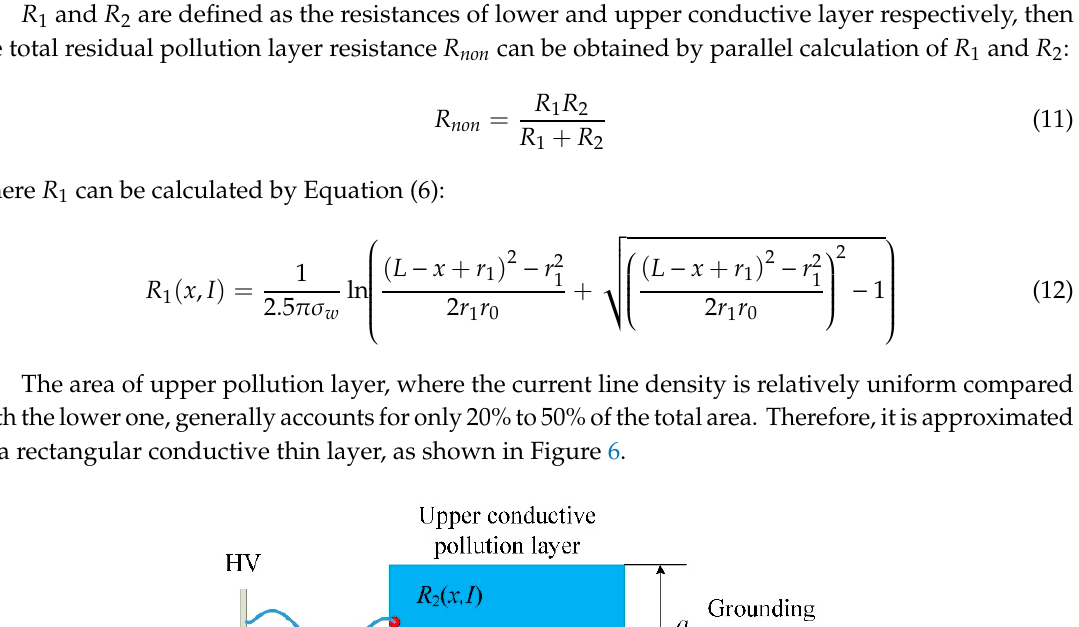
Figure 5. Conductive layers under non-uniform pollution between windward side and leeward side.